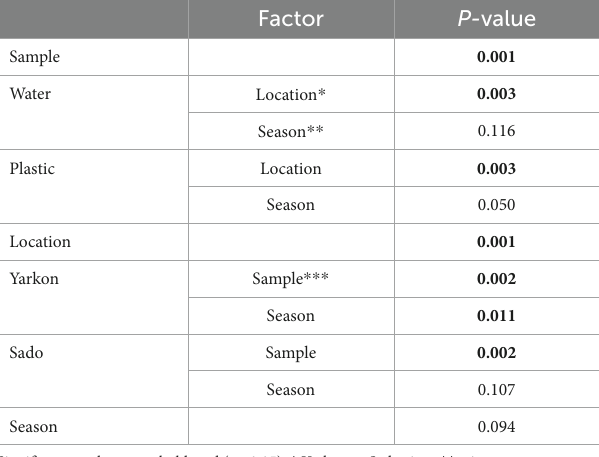
TABLE 2 P -values of PERMANOVA comparisons performed on bacterial communities.